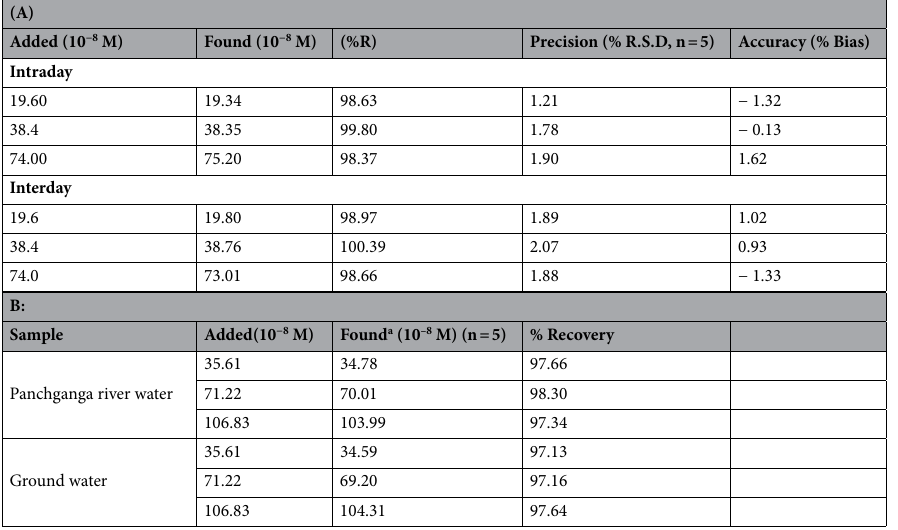
Table 2. (A) Precision and accuracy analysis for p-nitrophenol in pre-analyzed samples by the developed method (SW-AdSV), (B) Percentage recovery assay for p-nitrophenol in real water samples by the developed procedure (SW-AdSV). a Average of five